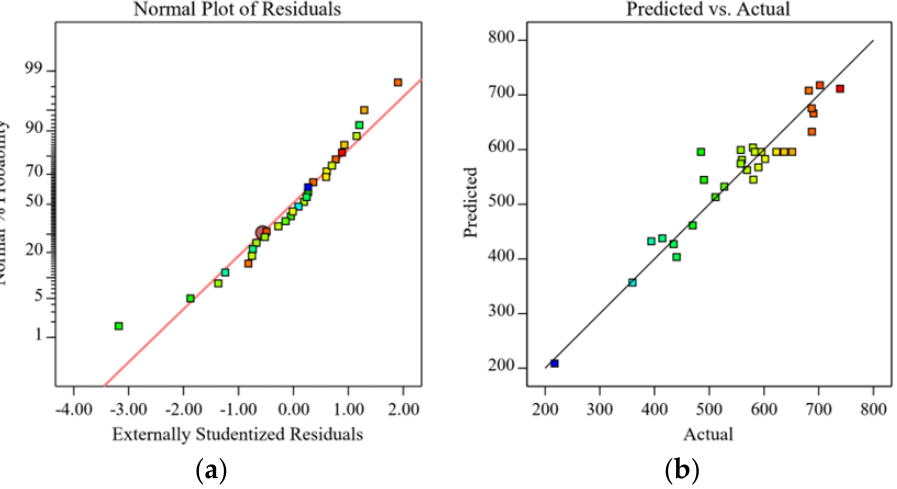
Figure 5. Normal probability plot of the residuals of the compression modulus of CNT/GN-RTV composites ( a ); ( b ) predicted versus actual values.